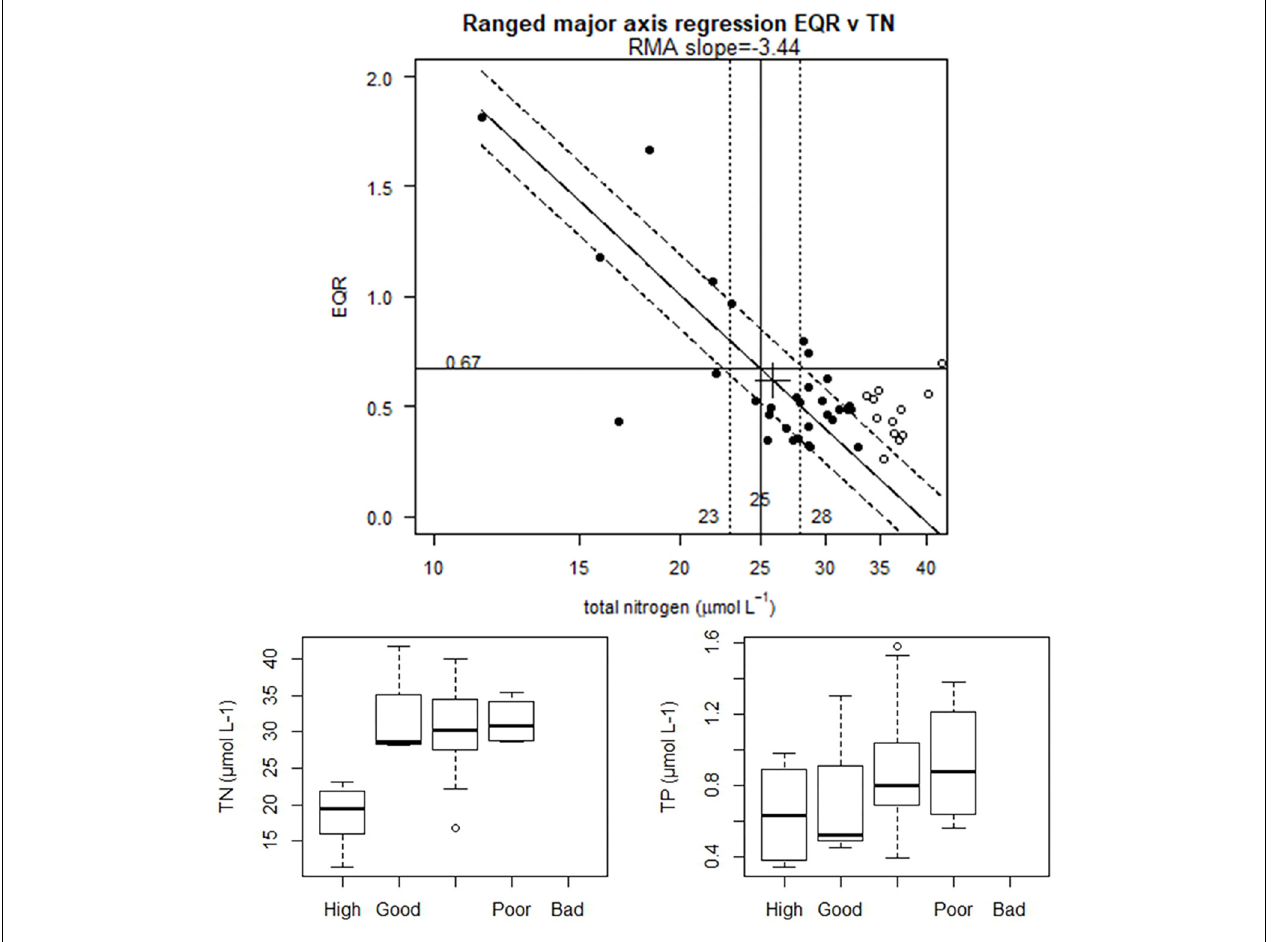
FIGURE 2 | Baltic coastal waters (CWs) type BC4 (Estonian data): RMA type II regression of EQR v log10 Total Nitrogen (TN) concentration (top). Nutrient values back transformed for plotting. Solid points are the values used for models, open circles are the excluded values beyond linear region. Black cross marks mean of data. Solid lines show fitted regression, broken lines upper and lower (25th, 75th) quantiles of residuals. Good/Moderate boundary point marked, as well as likely boundary range (25th, 75th). Bottom panels show range of nitrogen (TN) and phosphorus (TP) concentrations across ecological quality status (EQS) classes: High, Good, Moderate, Poor and